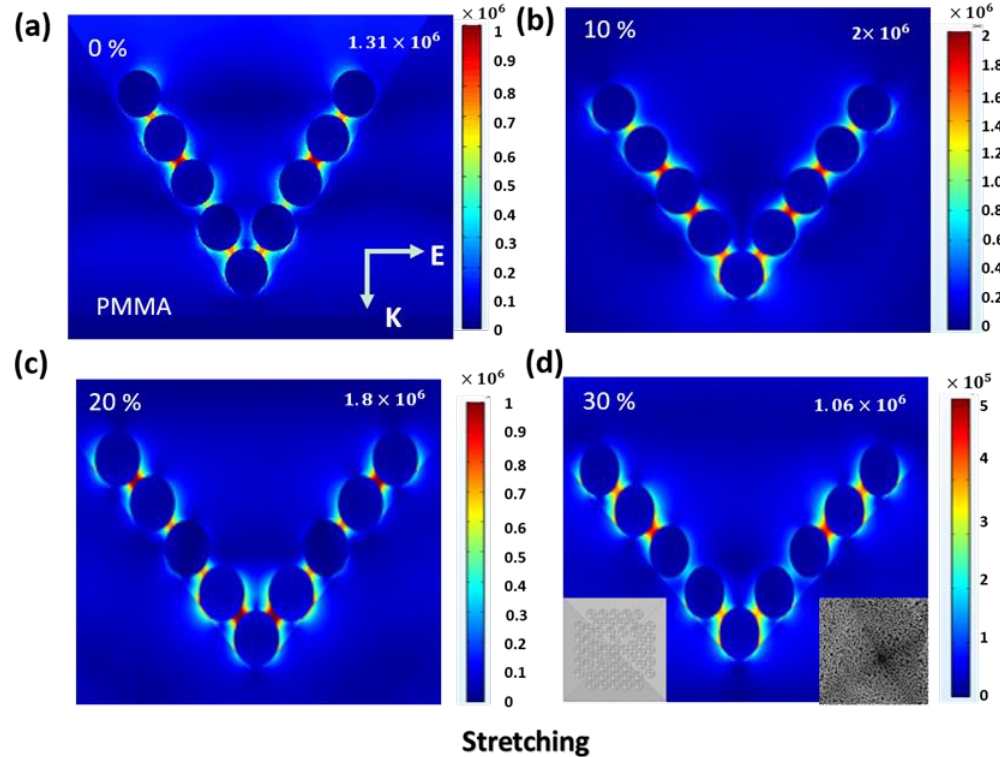
Figure 7. The respective Y–Z views of the electric filed distributed on the P–AgNPs@PMMA substrate after stretching to ~0% ( a ), 10% ( b ), 20% ( c ), and 30% ( d ).